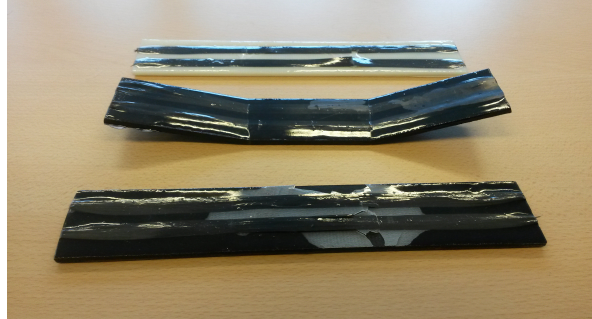
Figure 4. The grey rectangle on the top and the two black rectan- gles below it are the 3-D printed samples post fracture, placed on a sandstone-coloured desktop that forms the background. Top: ABS M30; middle: PC-ABS; bottom: nylon.